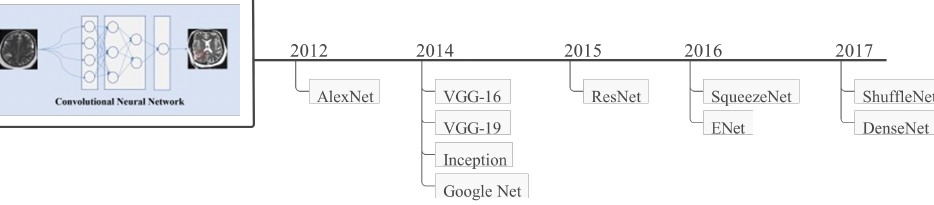
Figure 2. Some of the most well-known CNN models, along with their development time